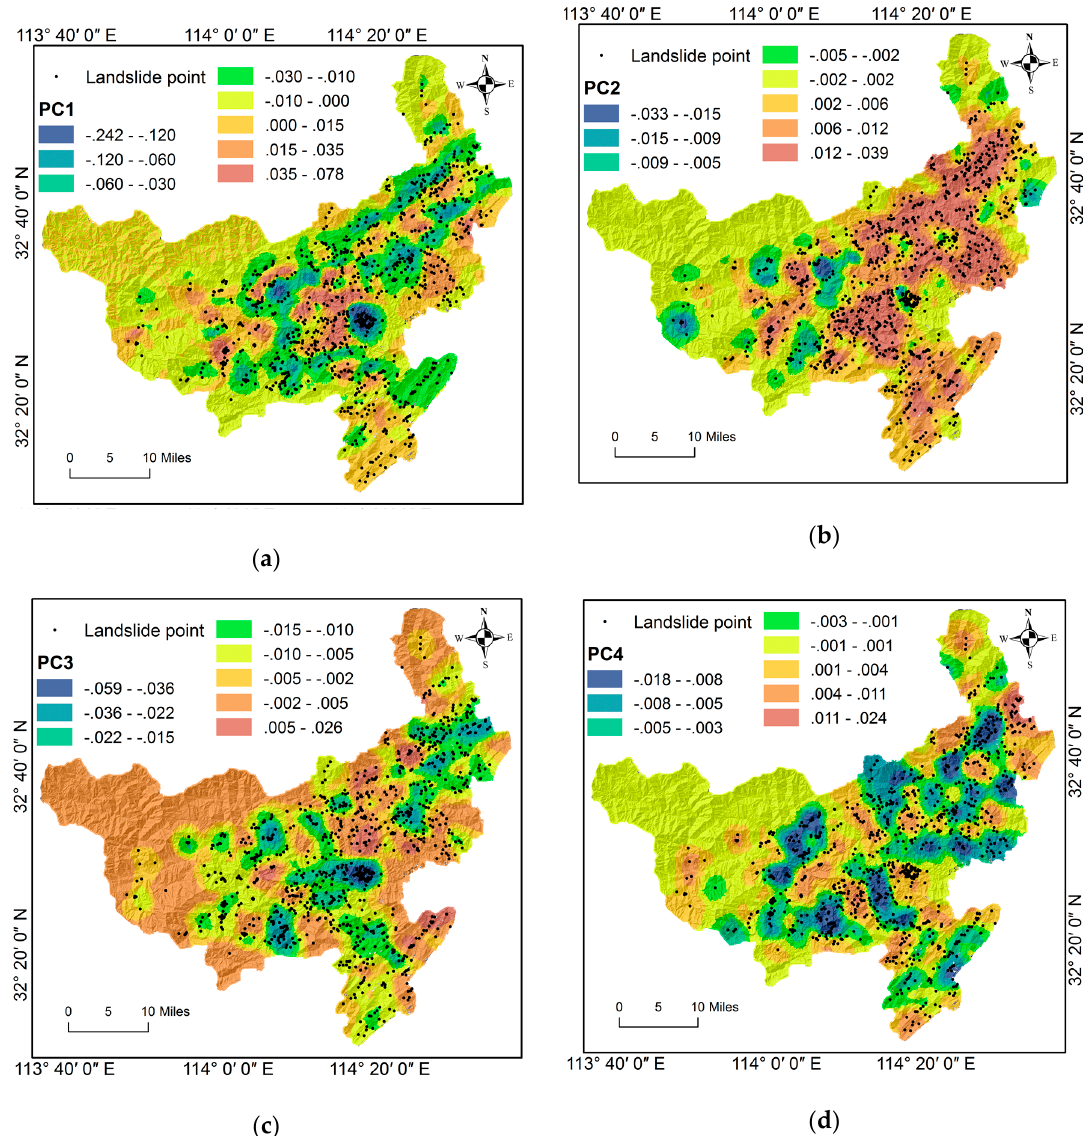
Figure 5. Spatial distribution of the principal component coefficient function estimate. ( a ) Regression coefficient of geological factor (PC1); ( b ) Regression coefficient of slope shape factor (PC2); ( c ) Regression coefficient of hydrographic factor (PC3); ( d ) Regression coefficient of aspect factor (PC4)).